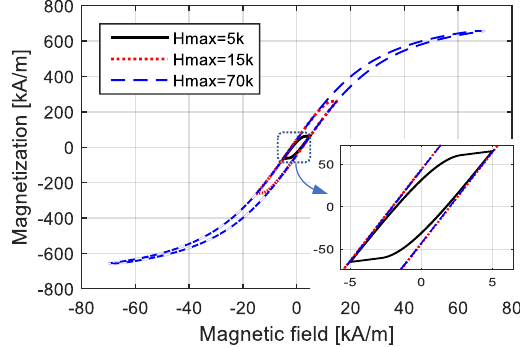
Figure 4. M − H curves with different amplitudes.